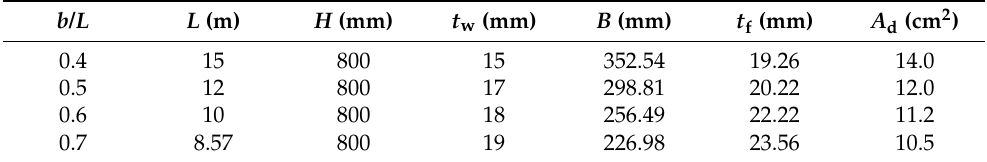
Table 2. Detailed sectional dimensions of the